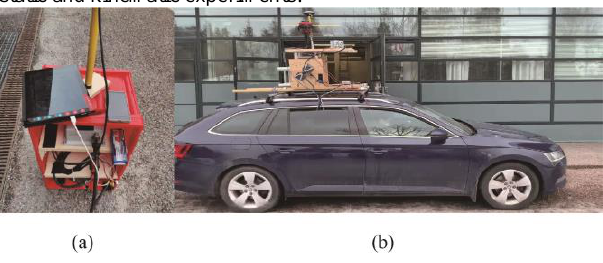
Figure 1 . The scenes and the equipment of the static and kinematic experiments. (a) is used for the static experiment. (b) is used for the kinematic experiment.